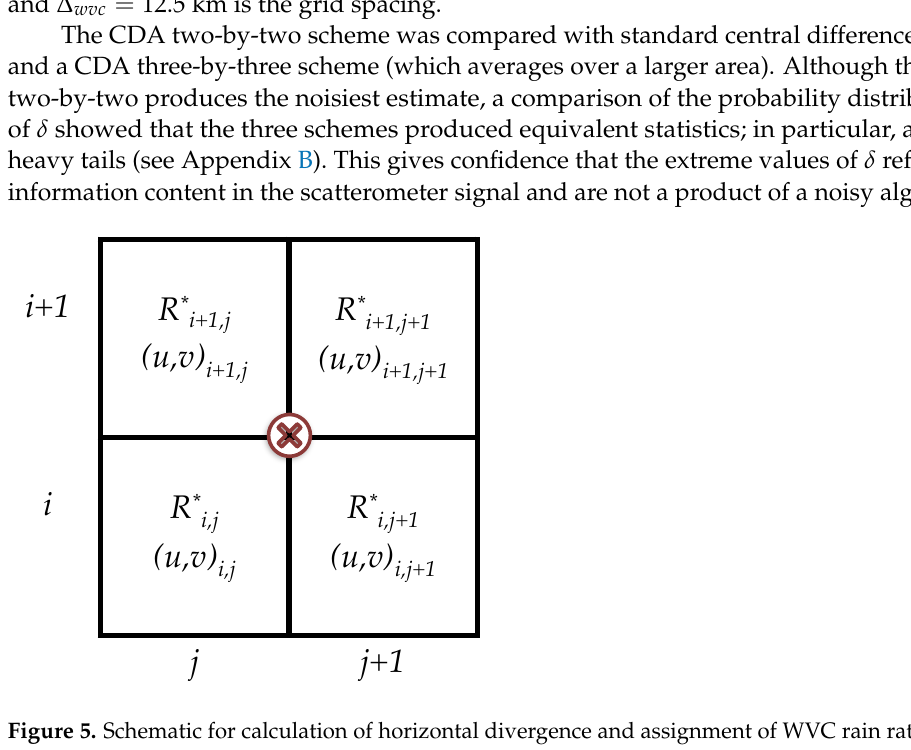
Figure 5. Schematic for calculation of horizontal divergence and assignment of WVC rain rate. Wind divergence is assigned to half-grid point ( i + 1/2, j + 1/2 ) . R ∗ spanned by WVC ( i , j )